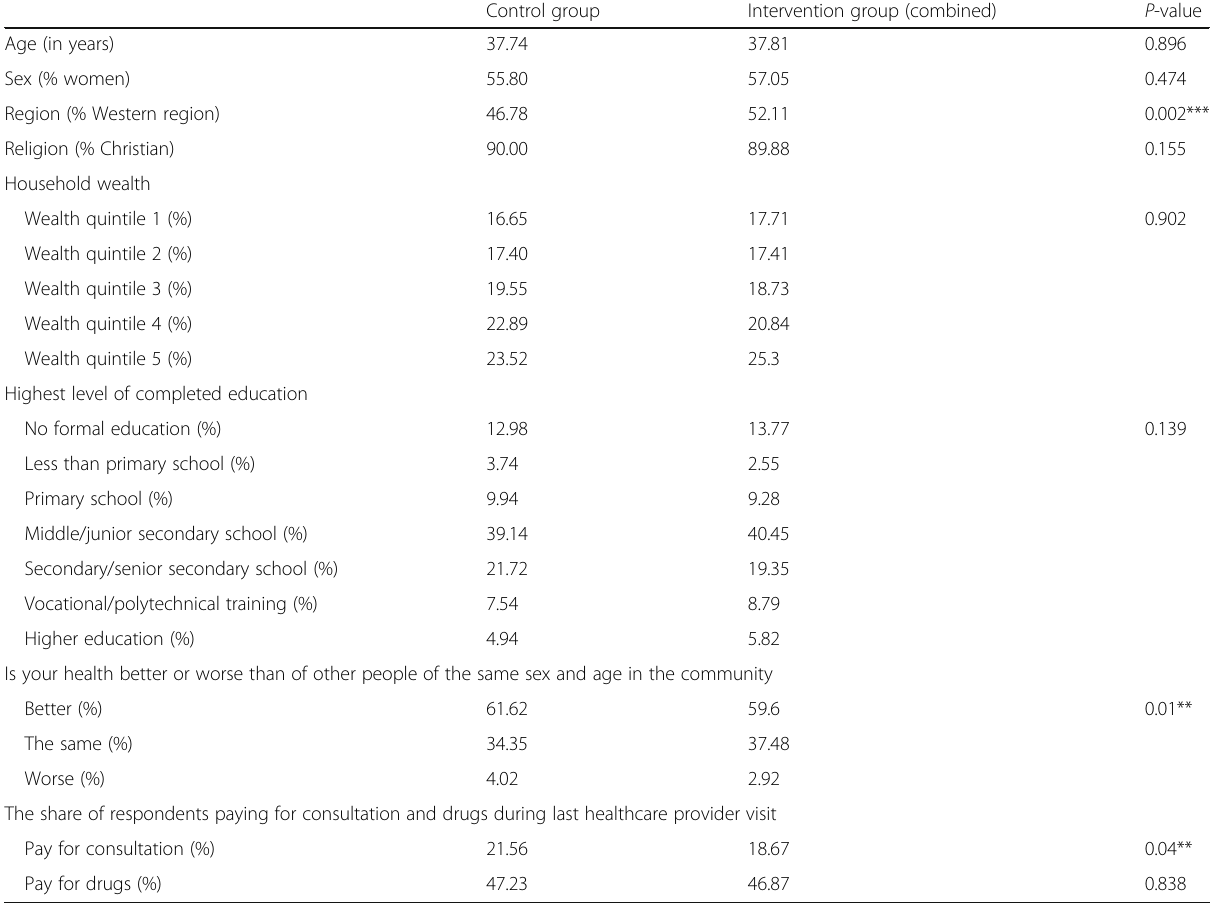
Table 1 Intervention group characteristics at baseline